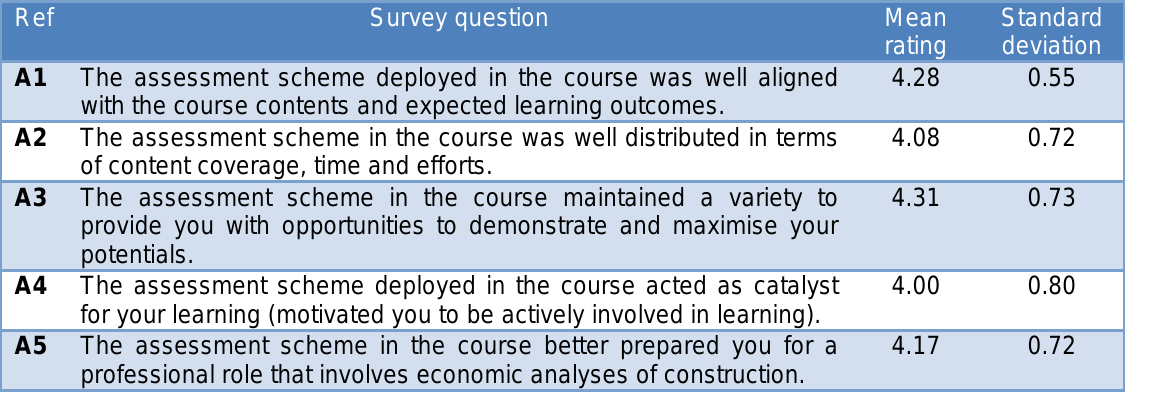
Standard rating deviation